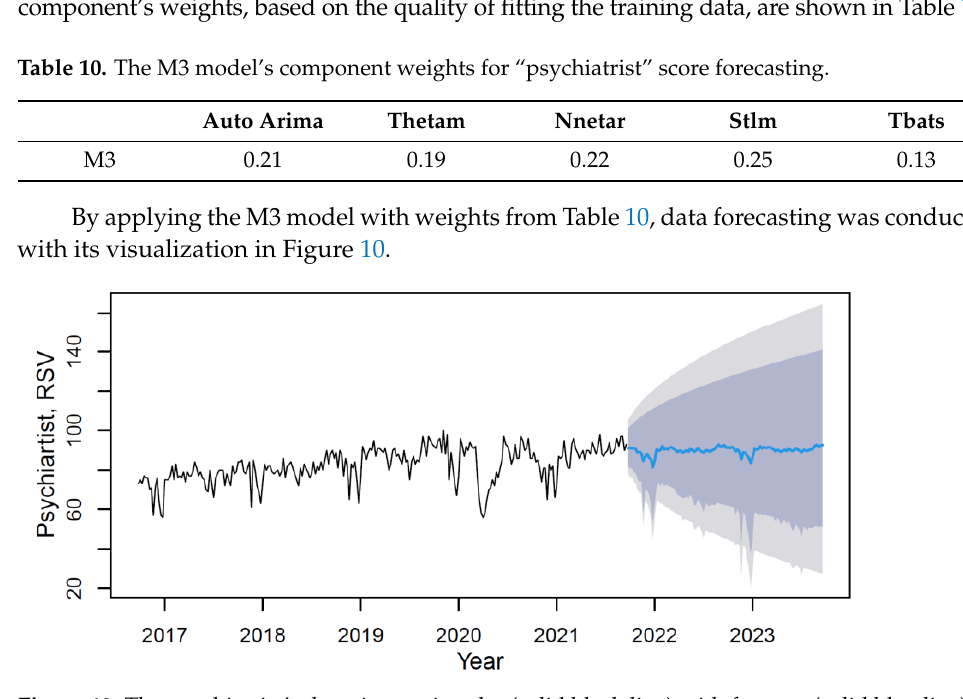
with the period under review by 8.4%. Given the relatively stable values of the forecasted RSV in 2021 – 2023, the main reason for the growth lies in the significantly lower compar- ative indicators in the period until 2019. 4. Discussion The purpose of this study was to investigate and predict the impact of the COVID-19 pandemic on population mental health. In our study, changes in search terms related to mental health during the COVID- 19 pandemic were observed. Queries about “depres- sion” were high during the first spring quarantine in 2020 ; however, in the carried out forecast, this expression is predicted to decrease between September 2021 and September 2023 by 15.3%. The decrease in “depression” queries was also noted in the study con- ducted by Reger et al. The authors explain it as the outcome of social coherence and the use of adaptive coping strategies [35]. In the study conducted from 27 April to 13 May 2020, as many as 50.9% of participants showed signs of anxiety, 57.4% of respondents suf- fered from stress, and 58.6% showed features of depression. According to the authors, stress and depression are globally prevalent during the COVID-19 pandemic [36]. More- over, in the study conducted in Hong Kong, 19% out of 500 respondents showed signs of depression in the spring of 2020 [37]. Interestingly, another study showed that the occur- rence rate of depression was strongly associated with the time spent on COVID-19 related reports. The depression rate was 17.8% among people who spent less than five minutes daily on COVID-19 related news and oscillated near 28% among individuals who fol- lowed the topics daily for one hour [38]. As presented in our study, the high interest in inquiries about “depression” shortly after the pandemic outbreak might mimic this public interest. The WHO advises to minimize listening to news related to the COVID-19 pan- demic that may cause anxiety. Only trusted sources should be followed to gain more in- formation on the protection against the virus [39]. Insomnia is a serious health problem associated with a high psychological burden and is also considered as one of the symptoms of depression. A Greek scientific report revealed that 37.6% of 2,363 study participants had sleep problems. Women and urban dwellers were more likely to have sleep problems, while younger persons did not show this significant trend. Elevated insomnia scores occurred in subjects who were unsure whether they or their family members were infected with the virus. Finally, according to the analysis, higher levels of future uncertainty, COVID-19-related distress, loneliness, and depressive symptoms were predictors of insomnia [40].